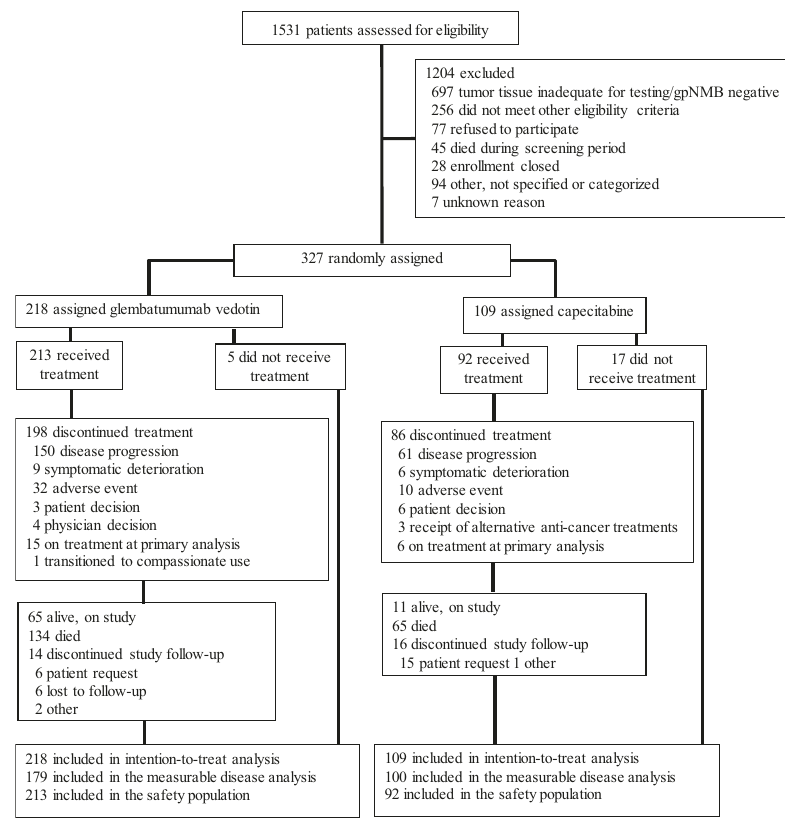
Fig. 1 METRIC trial patient